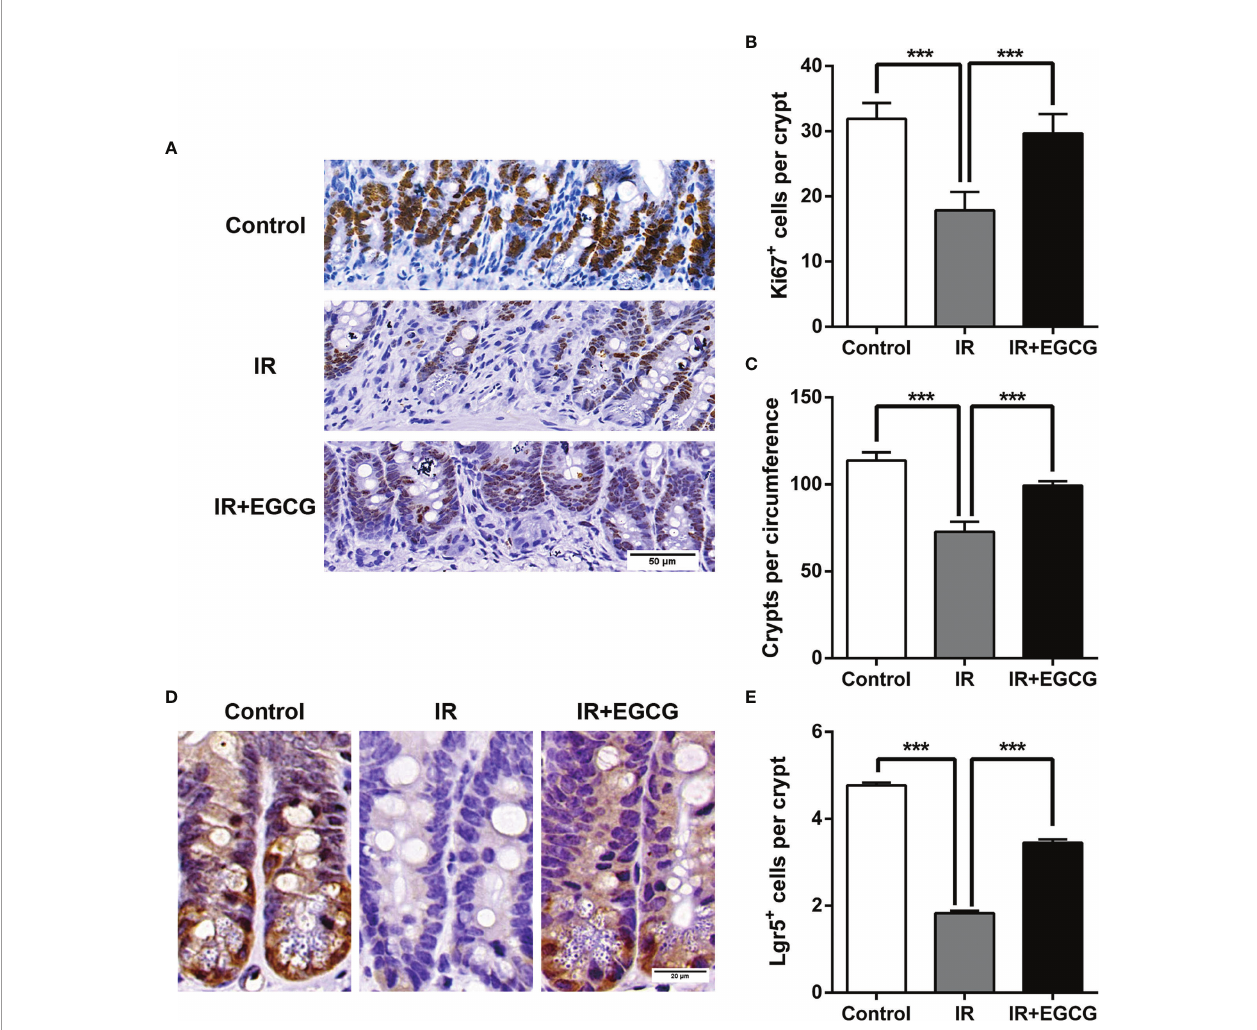
FIGURE 2 | EGCG promotes the proliferation of crypt cells and the survival of ISCs after radiation. (A) Representative IHC images of intestinal tissues showing the in situ expression of Ki67 in the indicated groups at 5 days after TBI (Scale bar = 50 m m). (B, C) Histograms showing the number of Ki67 + cells per crypt and surviving crypts per circumference in the different groups. The crypts with more than 10 Ki67 + cells were considered as surviving crypts. (D) Representative IHC images showing the in situ expression of Lgr5 in the indicated groups at 5 days after TBI (Scale bar = 20 m m). (E) Histogram showing the number of Lgr5 + ISCs per crypt at 5 days post-TBI. Results are presented as mean ± SEM. *** p < 0.001; n =